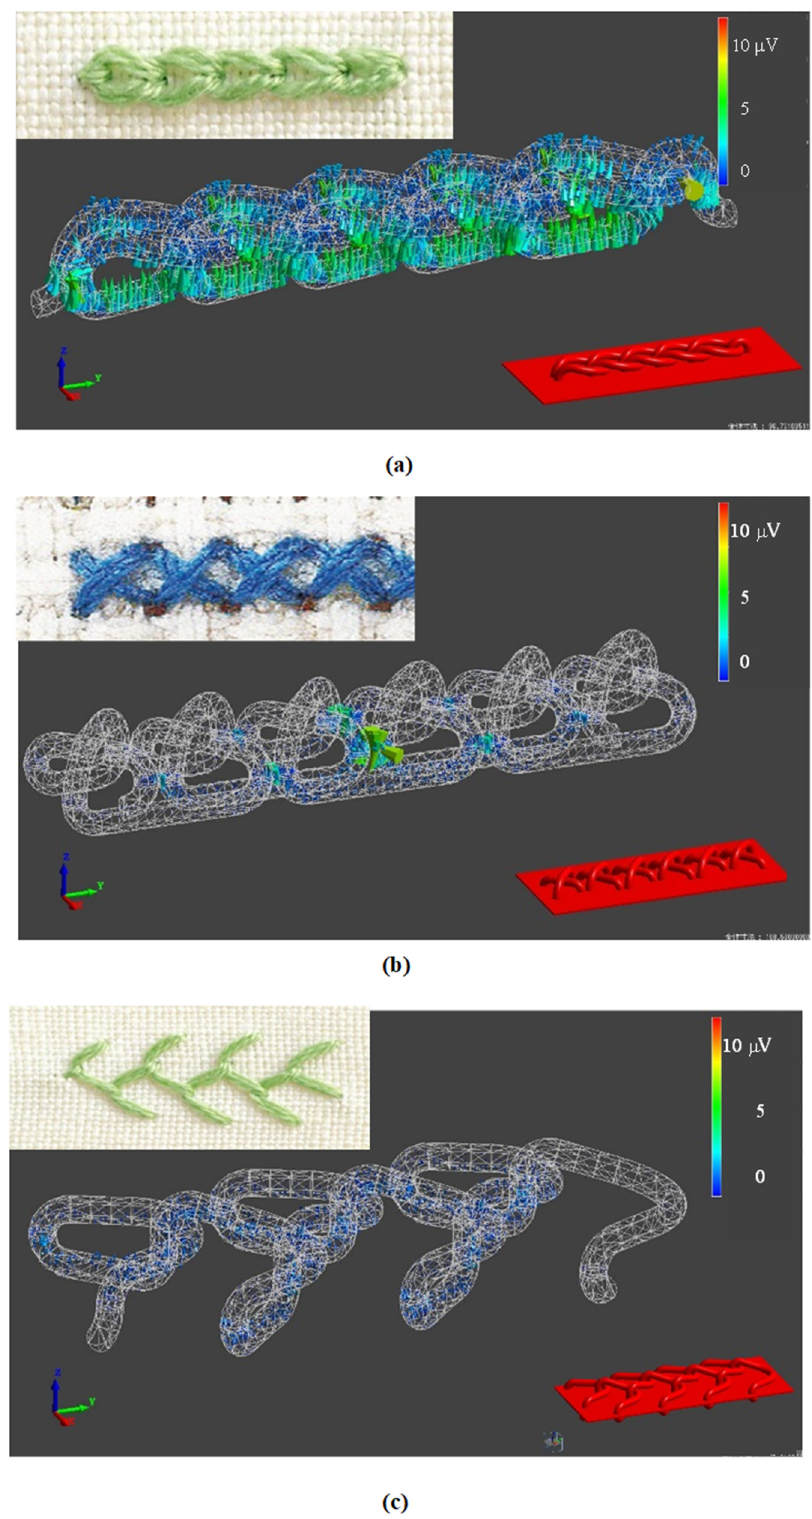
Figure 8. Piezoelectric response of piezoelectric braided cord embroidered using chain stitch ( a ), cross stitch ( b ), and feather stitch ( c ).